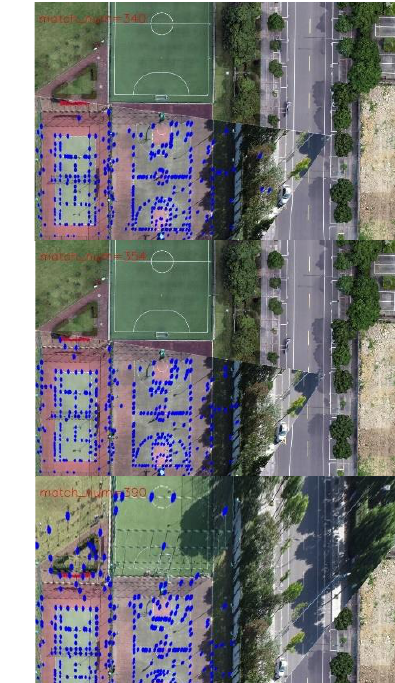
Figure 19. Registration image (without updating the map features).